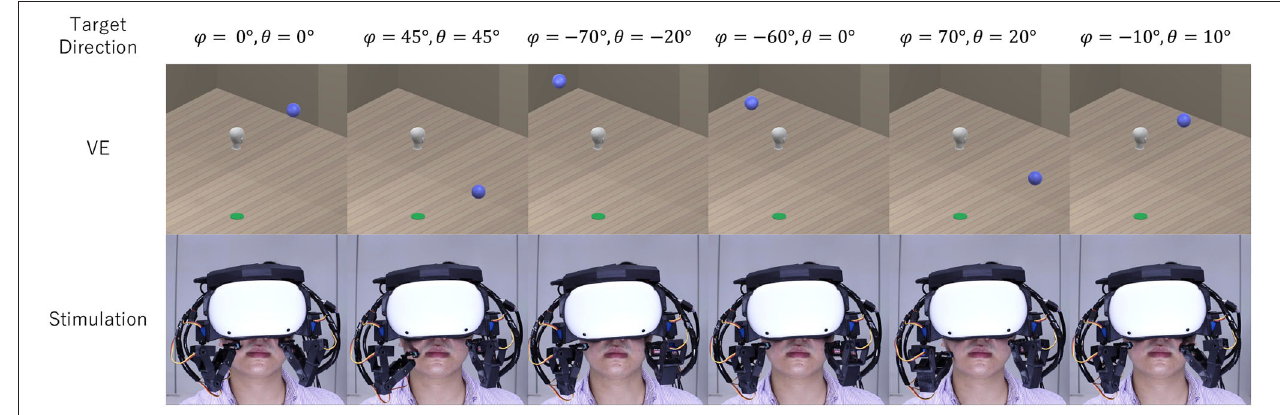
FIGURE 13 | Haptic directional cue presentation with robot arms attached to an HMD. The upper row showed a target’s direction, which was represented as azimuthal and elevational angles. The second row was a VE. The user’s head position was represented as a 3D head model.The blue sphere was a target. The bottom row was the user that stimulated the cheek with the robot